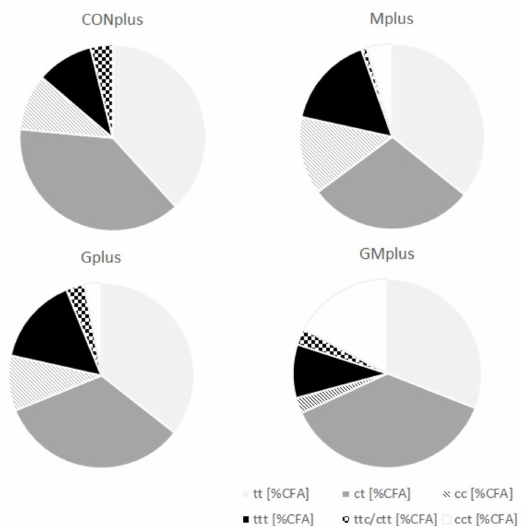
Figure 1. Detailed composition of di ff erent classes of conjugated fatty acid (CFA) isomers in mammary tumours of experimental